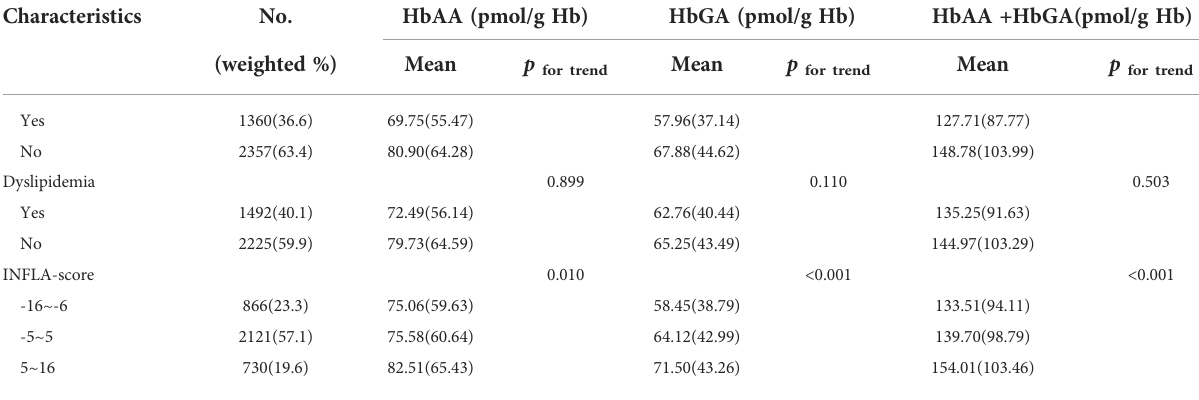
Table 1). Further, results for RCS models were showed in Figure 1. With the increase of AA biomarkers, the HRs for cancer mortality increased rapidly, presenting a dose-response